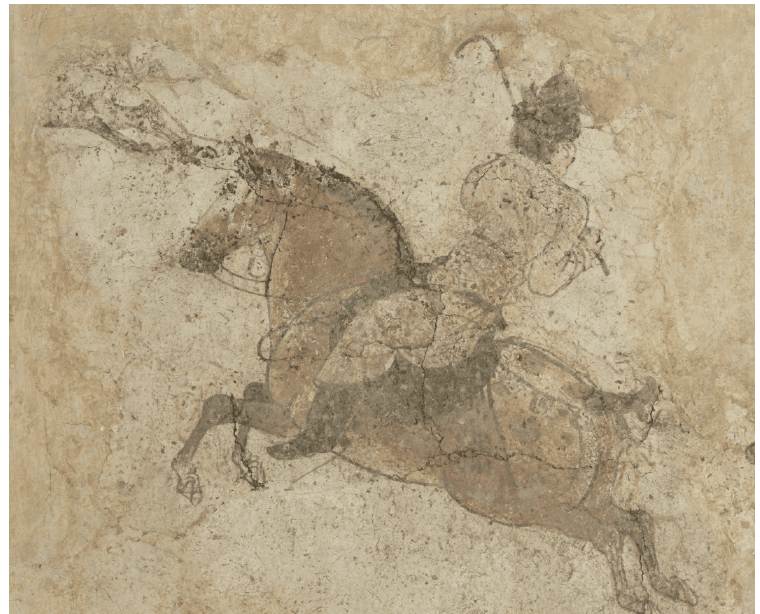
Figure 9. Dataset used in this paper